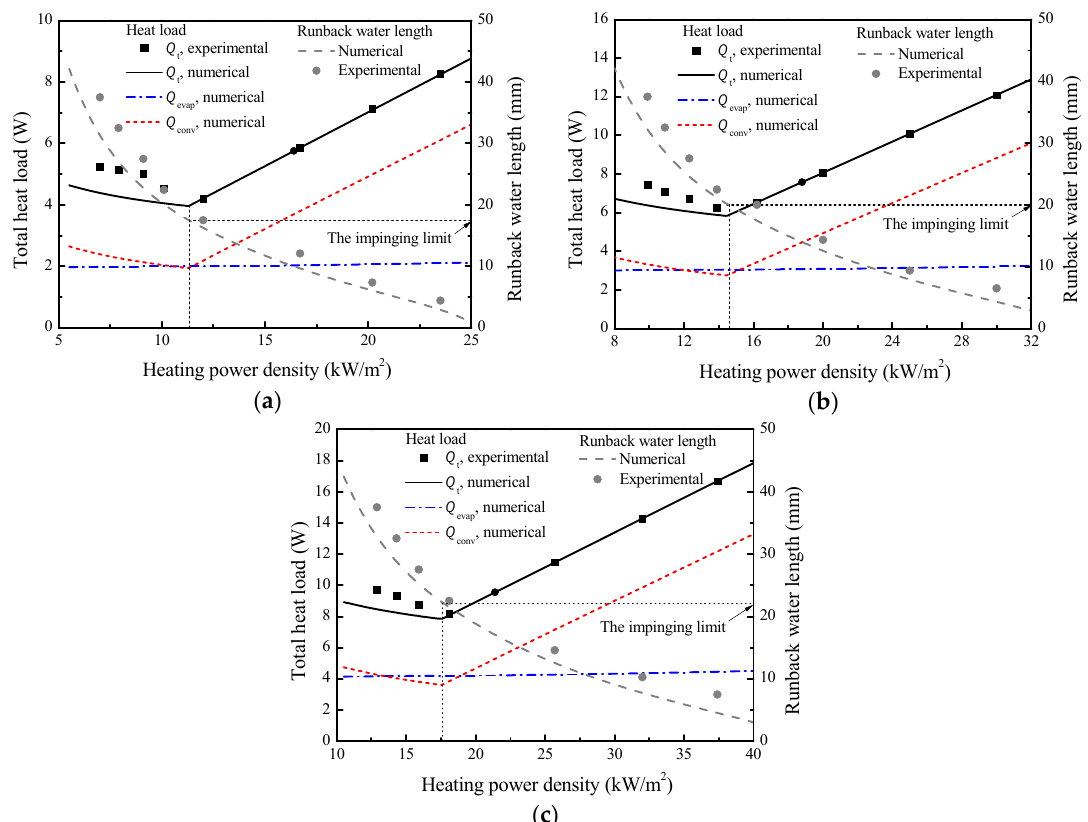
Figure 14. Relationship between the anti ‐ icing heat load and the heating range: ( a ) Case 1; ( b ) Case 2; ( c ) Case 3. ( c ) Case